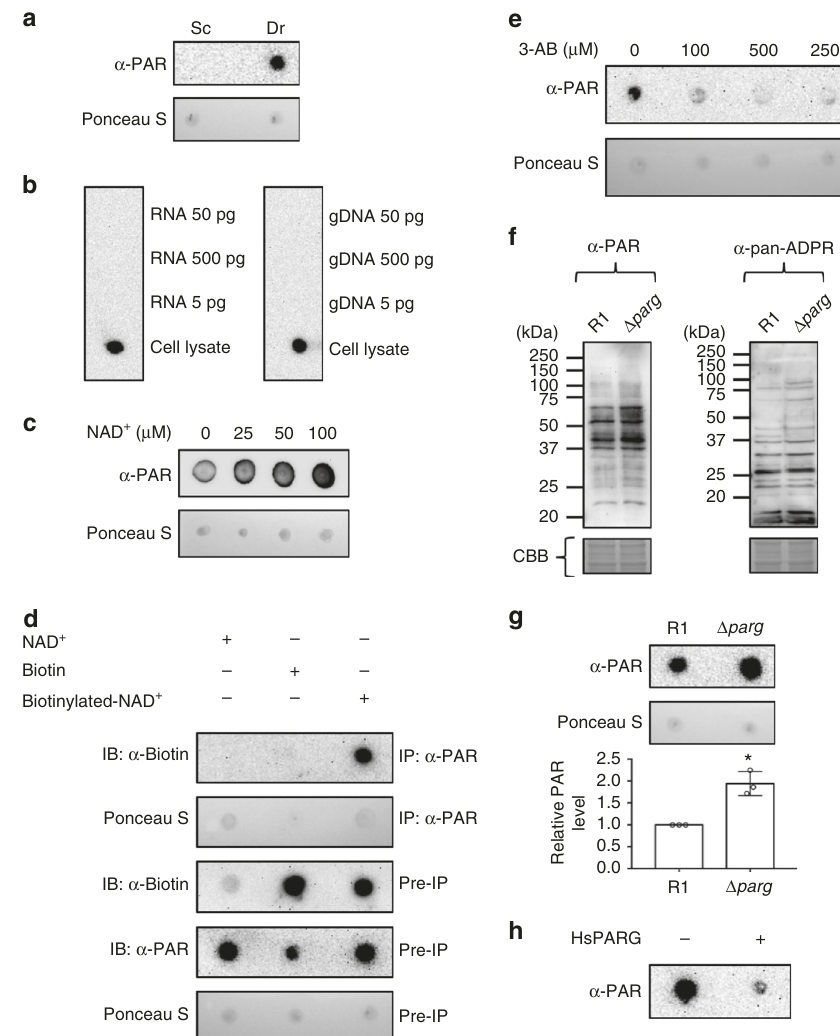
Fig. 3 Detection of endogenous poly-ADP-ribose (PAR) in Deinococcus radiodurans . a PAR formation assayed in cell lysates of D. radiodurans R1 (Dr) by dot blotting. The cell lysates of Saccharomyces cerevisiae BY4741 (Sc) were used as a negative control. The membrane was stained with Ponceau Red as a loading control. b Various amounts of genomic DNA and RNA of D. radiodurans R1 were spotted on nitrocellulose membrane and assayed for PAR signal by dot blotting. The cell lysates of R1 were used as a positive control. c PAR levels assayed by dot blotting in D. radiodurans R1 cultured with NAD + supplement. Ponceau Red staining is the loading control. d The incorporation of NAD + into endogenous PAR in D. radiodurans was assayed by co-immunoprecipitation (IP) and immunoblotting (IB). Biotin-labeled or -non-labeled NAD + was supplemented to R1 culture. Pre-IP or IPed samples were analyzed by indicated antibodies or Ponceau Red staining. R1 culture supplemented with biotin was used as a control for the entry of biotin-labeled NAD + into R1 cells. e PAR levels were assayed by dot blotting in D. radiodurans R1 culture treated with various amounts of 3-aminobenzamide (3-AB). Ponceau Red staining is the loading control. f The cell lysates of D. radiodurans R1 and Δ parg strains were resolved in 12% acrylamide gel and blotted with PAR antibody and anti-pan- ADP-ribose binding reagent. The gels were stained with Coomassie Brilliant Blue (CBB) as a loading control. g PAR formation was assayed in wild-type D. radiodurans R1 and Δ parg strains cultured in the TGY medium at 30 °C by dot blotting. The membrane was stained with Ponceau Red as a loading control. PAR levels were quanti fi ed by using ImageJ and plotted as mean ± SEM ( n = 3 independent experiments) relative to the R1 strain, with PAR levels set to 1. * P ≤ 0.05, determined by Student ’ s t -test. h The cell lysates of Δ parg strain were incubated with or without recombinant human PARG (PARG from Homo sapiens (HsPARG)) and PAR levels were assayed by dot blotting. Source data are provided as a Source Data fi